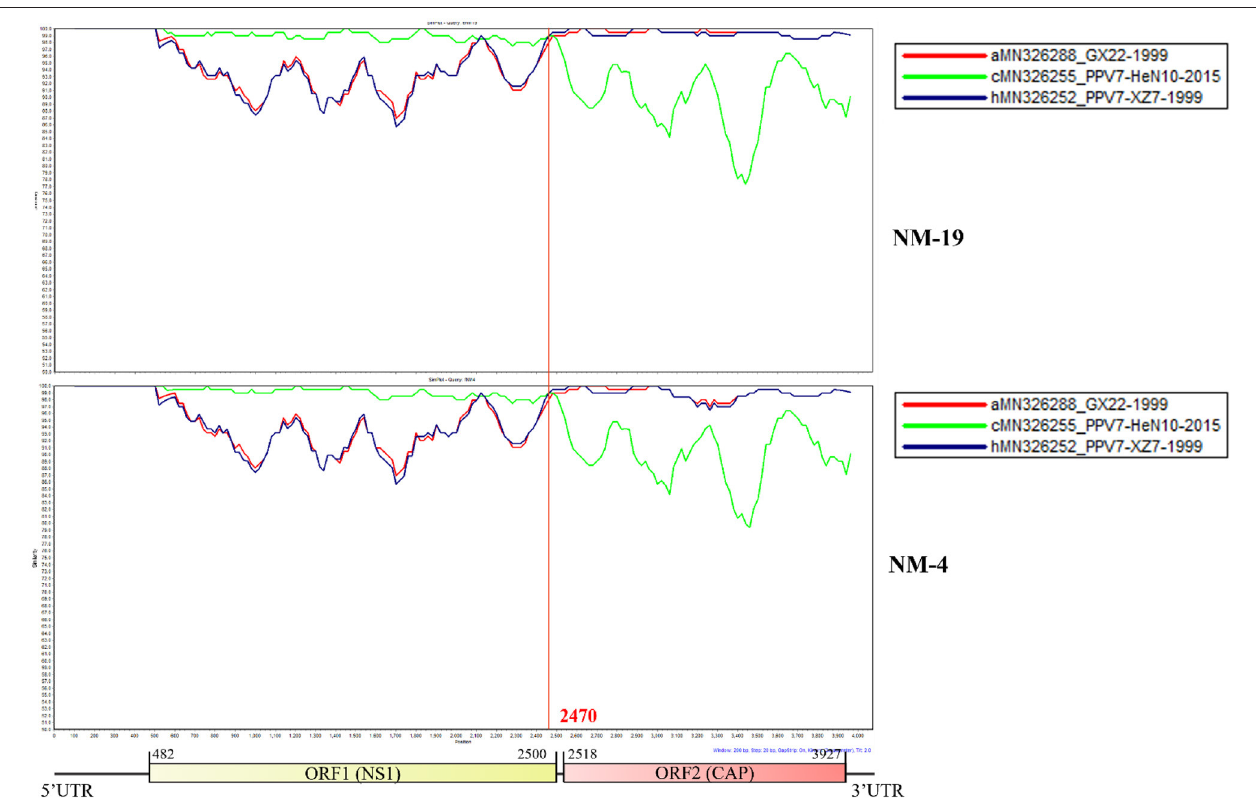
FIGURE 5 | Similarity plot of whole genomes of different porcine parvovirus 7. The isolate NM-19 strain or NM-4 strain was set as the query strain, respectively. The vertical and horizontal axes represent the nucleotide similarity percent and nucleotide position (bp) of the alignment in the graph, respectively.